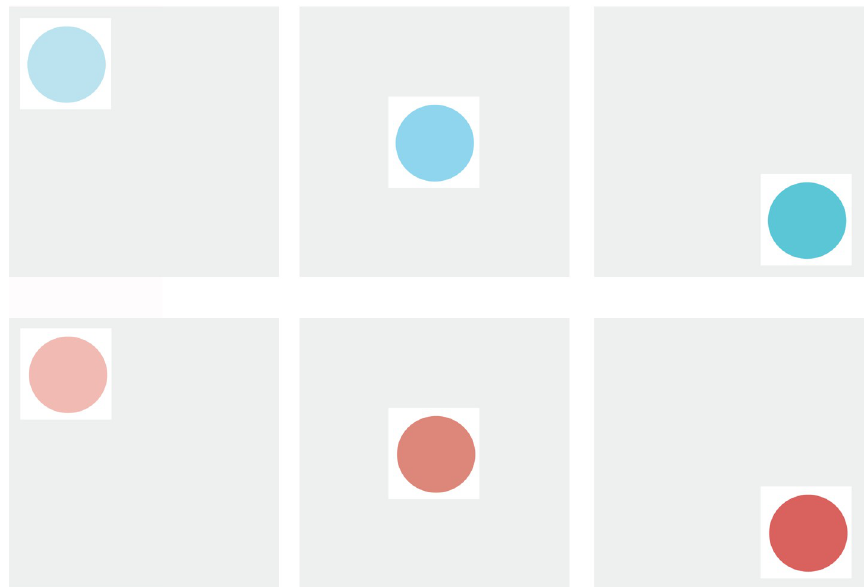
Fig 1. Stimuli examples. The three shades of the red and blue circles are shown set within 3 of the 9 available positions within the larger square background. RGB settings: Blue, 1) 185 224 234; 2) 145 211 234; 3) 95 197 214; Red, 1) 239 186 180; 2) 221 135 122; 3) 214 97 93.